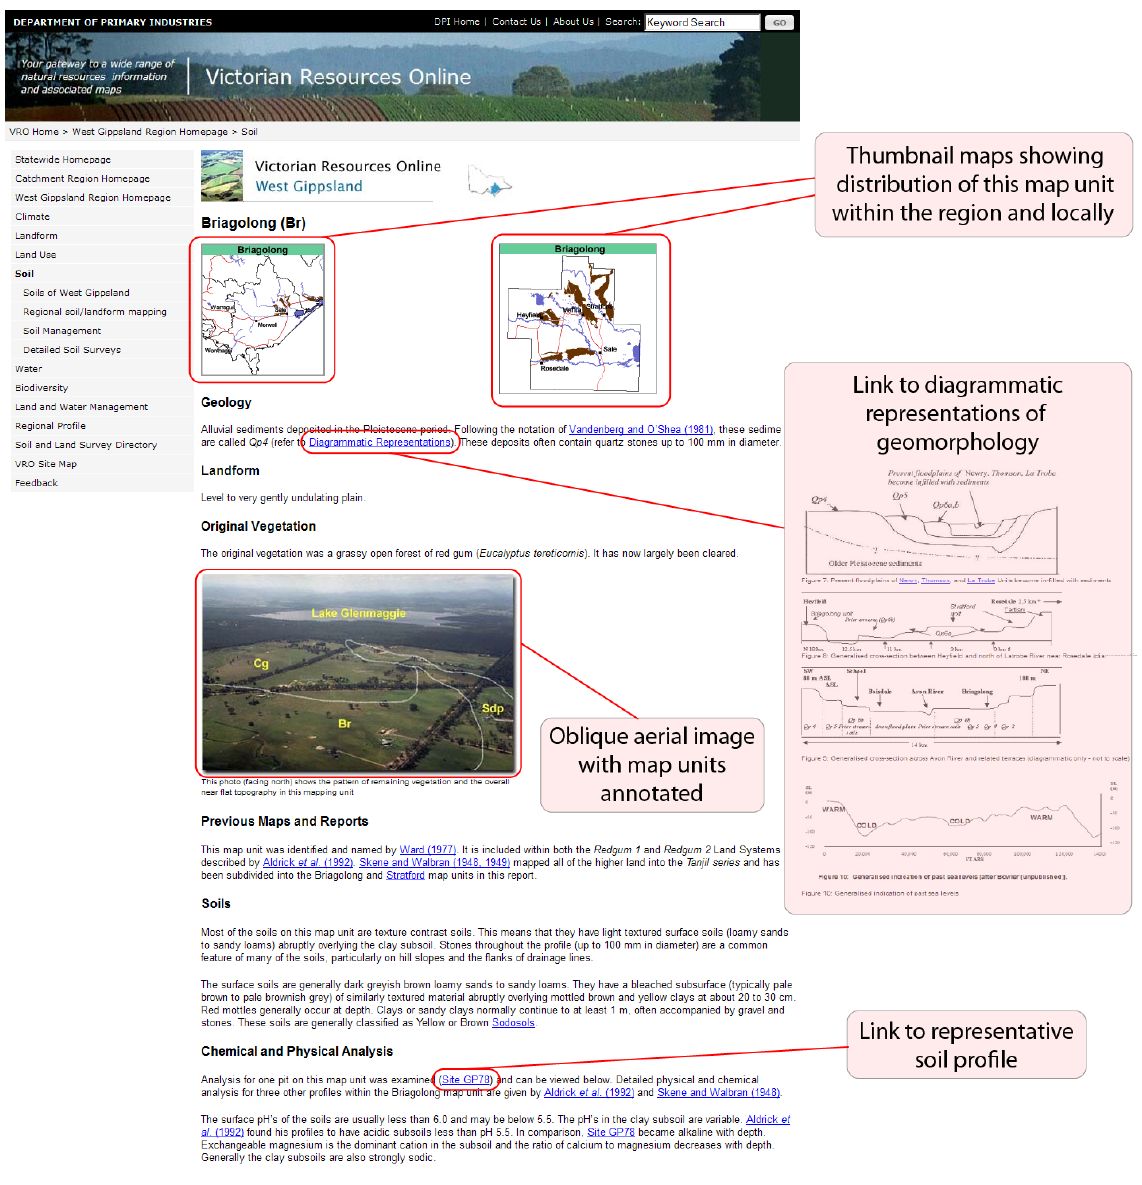
Figure 10. Map unit description webpage with annotated examples of information presentation, linking and contexting.  State of Victoria, Department of Primary Industries 1997 Reproduced with permission. From: